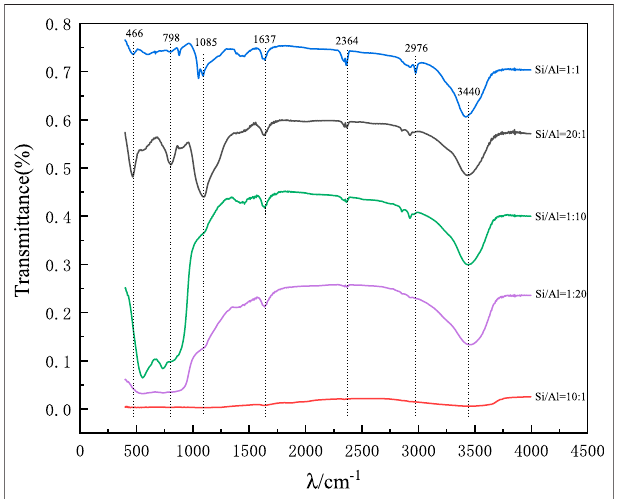
FIGURE 12 | IR spectra of mineral polymer precursors synthesized by different amounts of